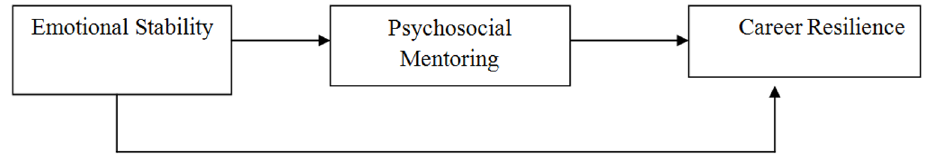
Figure 1. Proposed